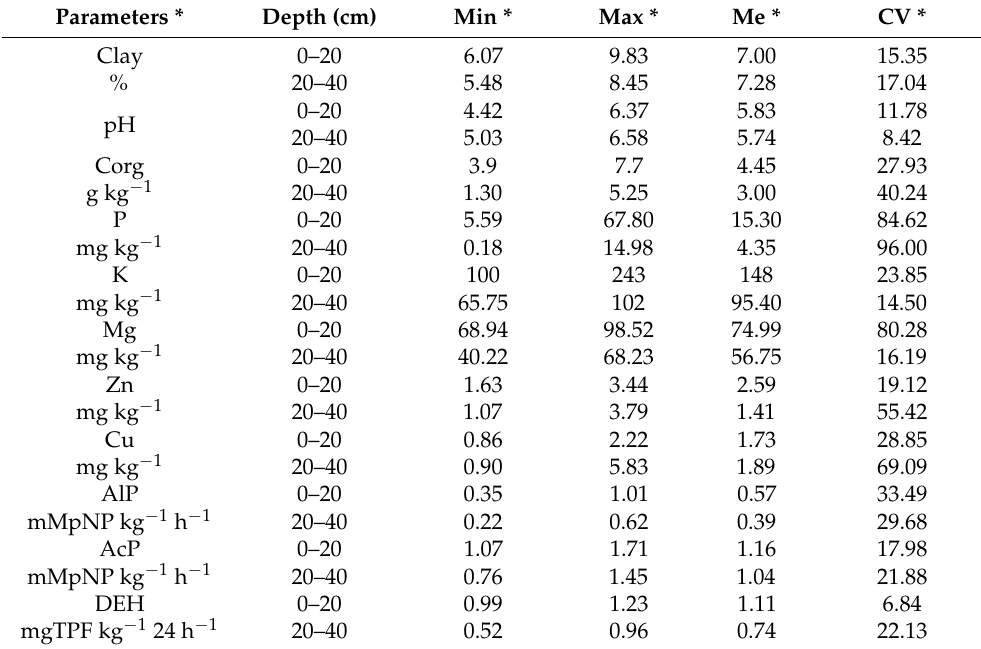
Table 2. Selected physicochemical and biochemical properties of the soil before the application of the distillery stillage (Control in 2018). Parameters * Depth (cm) Min